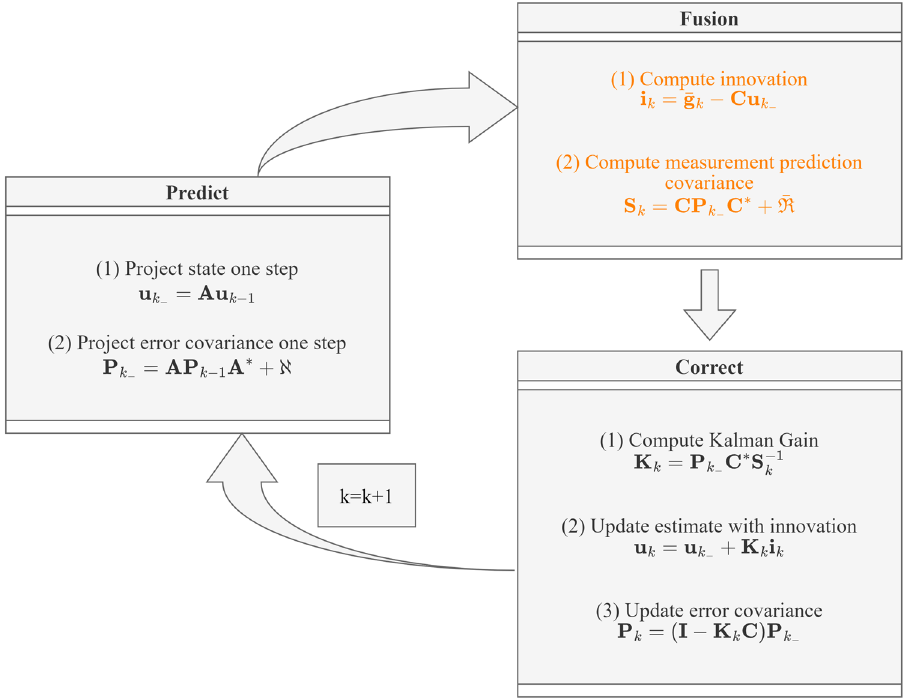
Figure 7. Fusion Kalman filter framework.